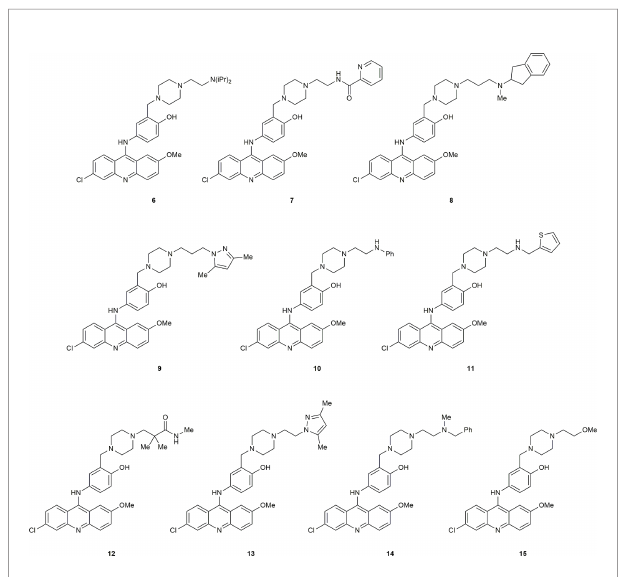
FIGURE 2 | Structures of compounds from in silico screening